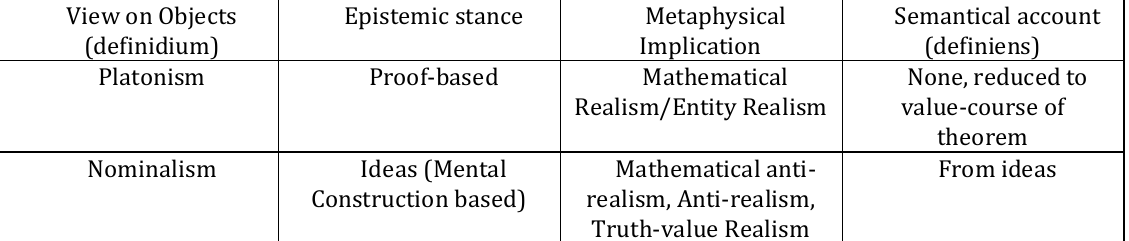
Table 1. Different views concerning mathematical objects conception